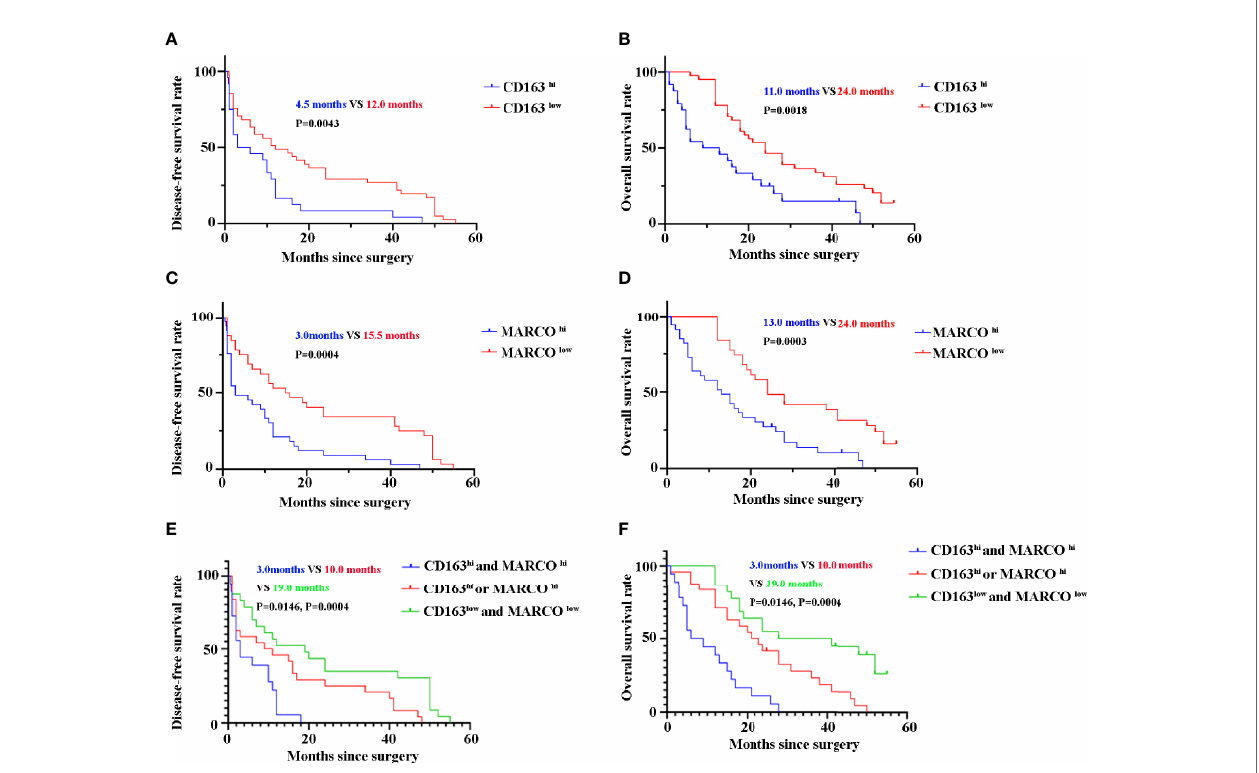
FIGURE 7 | The disease-free survival (DFS) and overall survival (OS) of pancreatic cancer patients between high and low expression of CD163 and MARCO. (A) DFS curve of patients with pancreatic cancer between CD163 hi and CD163 low . (B) OS curve of patients with pancreatic cancer between CD163 hi and CD163 low . (C) DFS curve of patients with pancreatic cancer between MARCO hi and MARCO low . (D) OS curve of patients with pancreatic cancer between MARCO hi and MARCO low . (E) DFS curve of patients with pancreatic cancer between CD163 hi MARCO hi and others. (F) OS curve of patients with pancreatic cancer between CD163 hi MARCO hi and others.